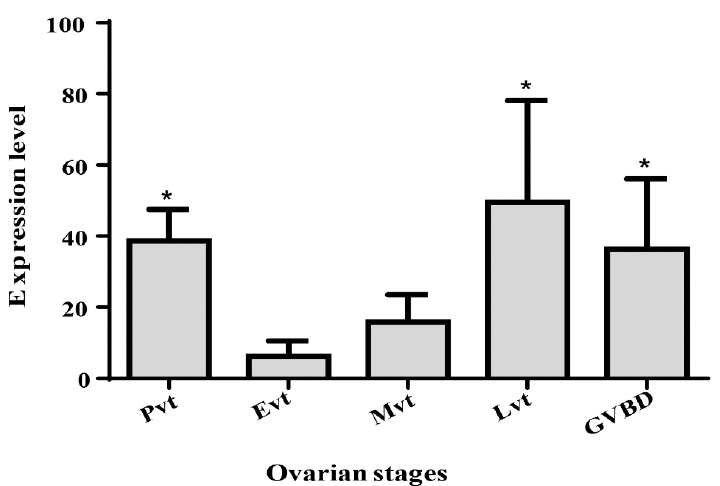
Figure 6. qPCR quantitation of EsLHR mRNA expression in the ovaries at various stages. Pvt, previtellogenic stage; Evt, early vitellogenic stage; Mvt, vitellogenic stage; Lvt, late vitellogenic stage; GVBD, germinal vesicle breakdown stage. Vertical bars represented mean ± SE ( n = 3). Significant different letters above the vertical bars indicate difference (* P < 0.05).